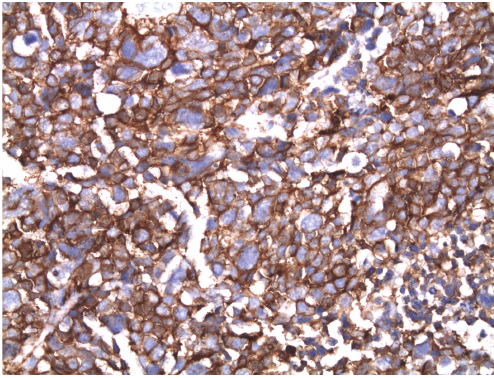
Figure 5: The Azzopardi phenomenon: basophilic dark blue DNA/nuclear chromatin liberated from dead cells coats vessel walls. (HE) × 400.